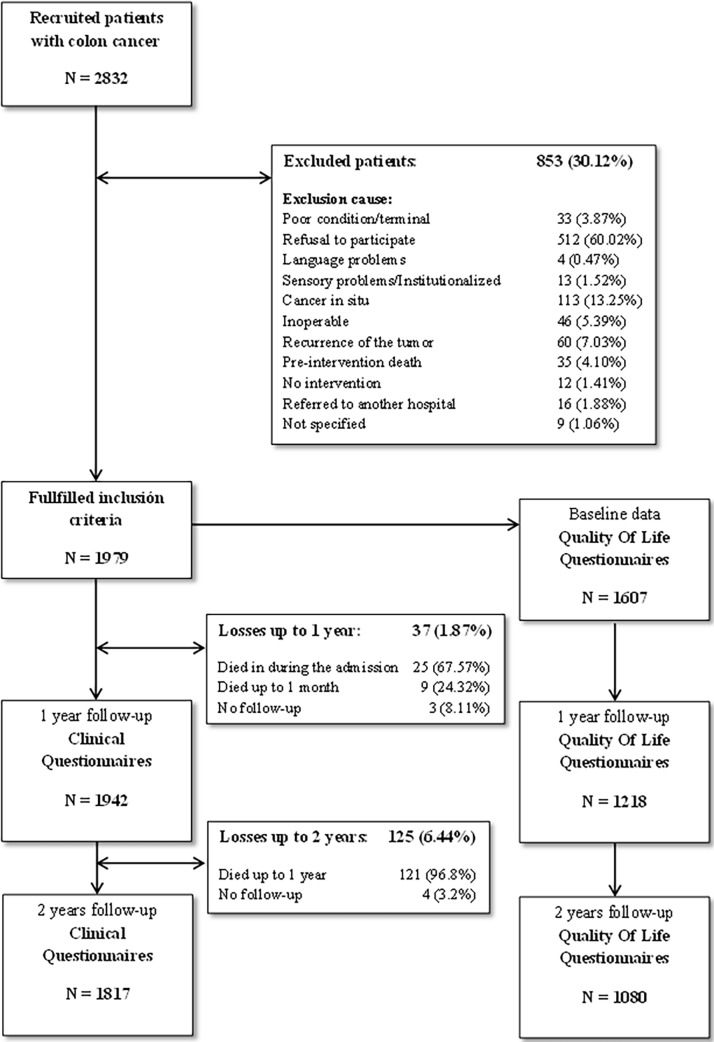
Flow-chart of the recruitment and follow-up process.